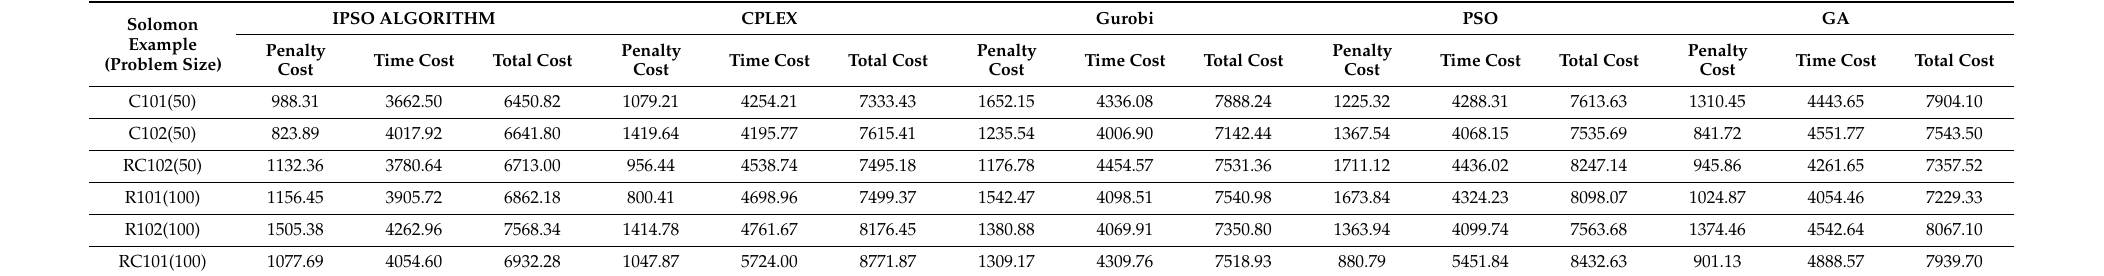
Table 9. Optimization results of different algorithms.